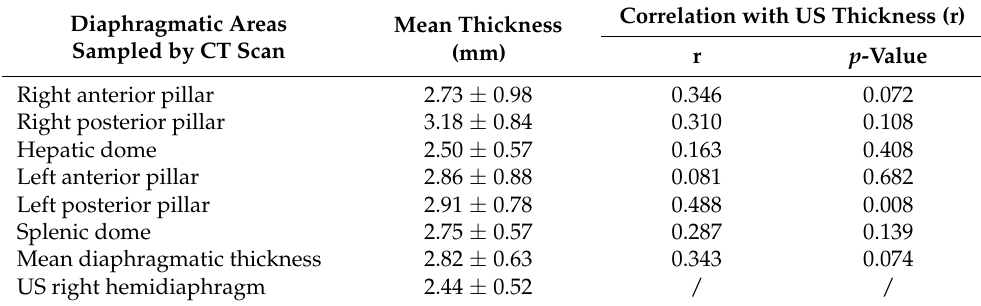
Figure 2. The mean diaphragmatic thickness measured using ultrasound (US right hemidiaphragm) and computed tomography (CT, at the level of different areas of the diaphragm). CT scan diaphrag- matic thickness at the level of left anterior, right posterior, left posterior pillars, and splenic dome is significantly thicker than US-based thickness. * p < 0.05 (two-tailed) versus US-based thickness. Table 1. Correlation between computerized tomography and ultrasound measurements of diaphrag- matic thickness. Diaphragmatic